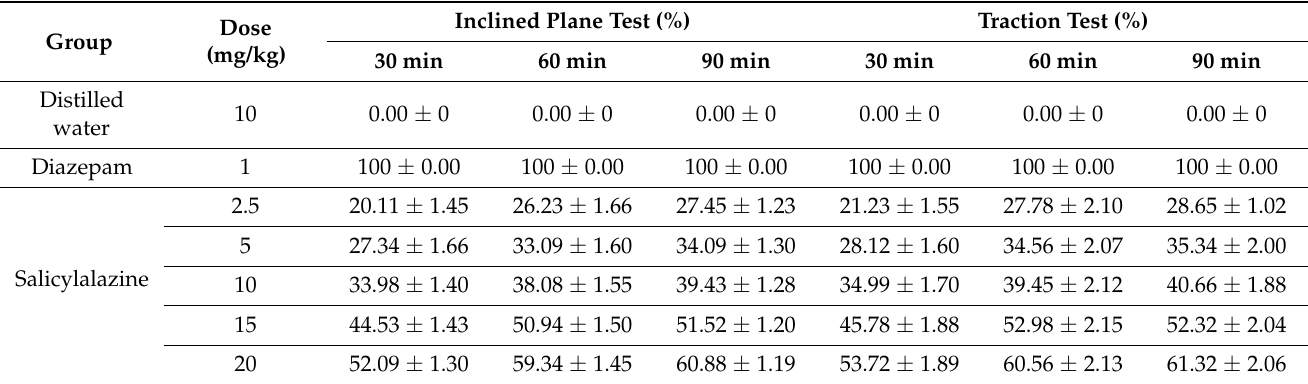
Table 2. Muscle relaxation potential of salicylalazine purified from M. biflora .